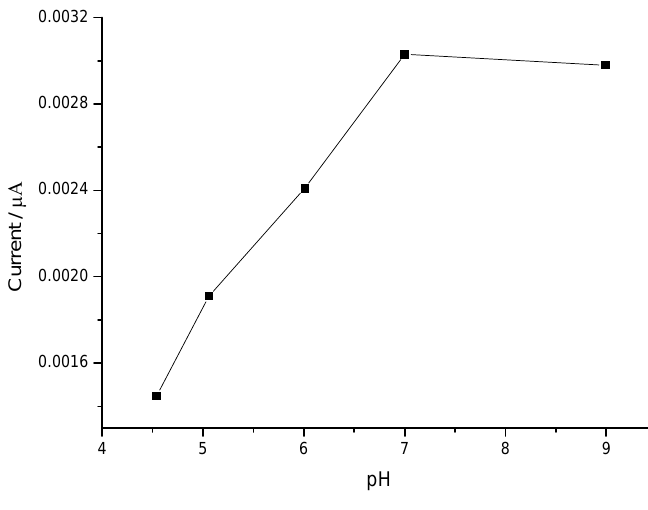
Figure 4. Effect of the pH on the response of the biosensor to 0.025 mM H the working potential of –0.25